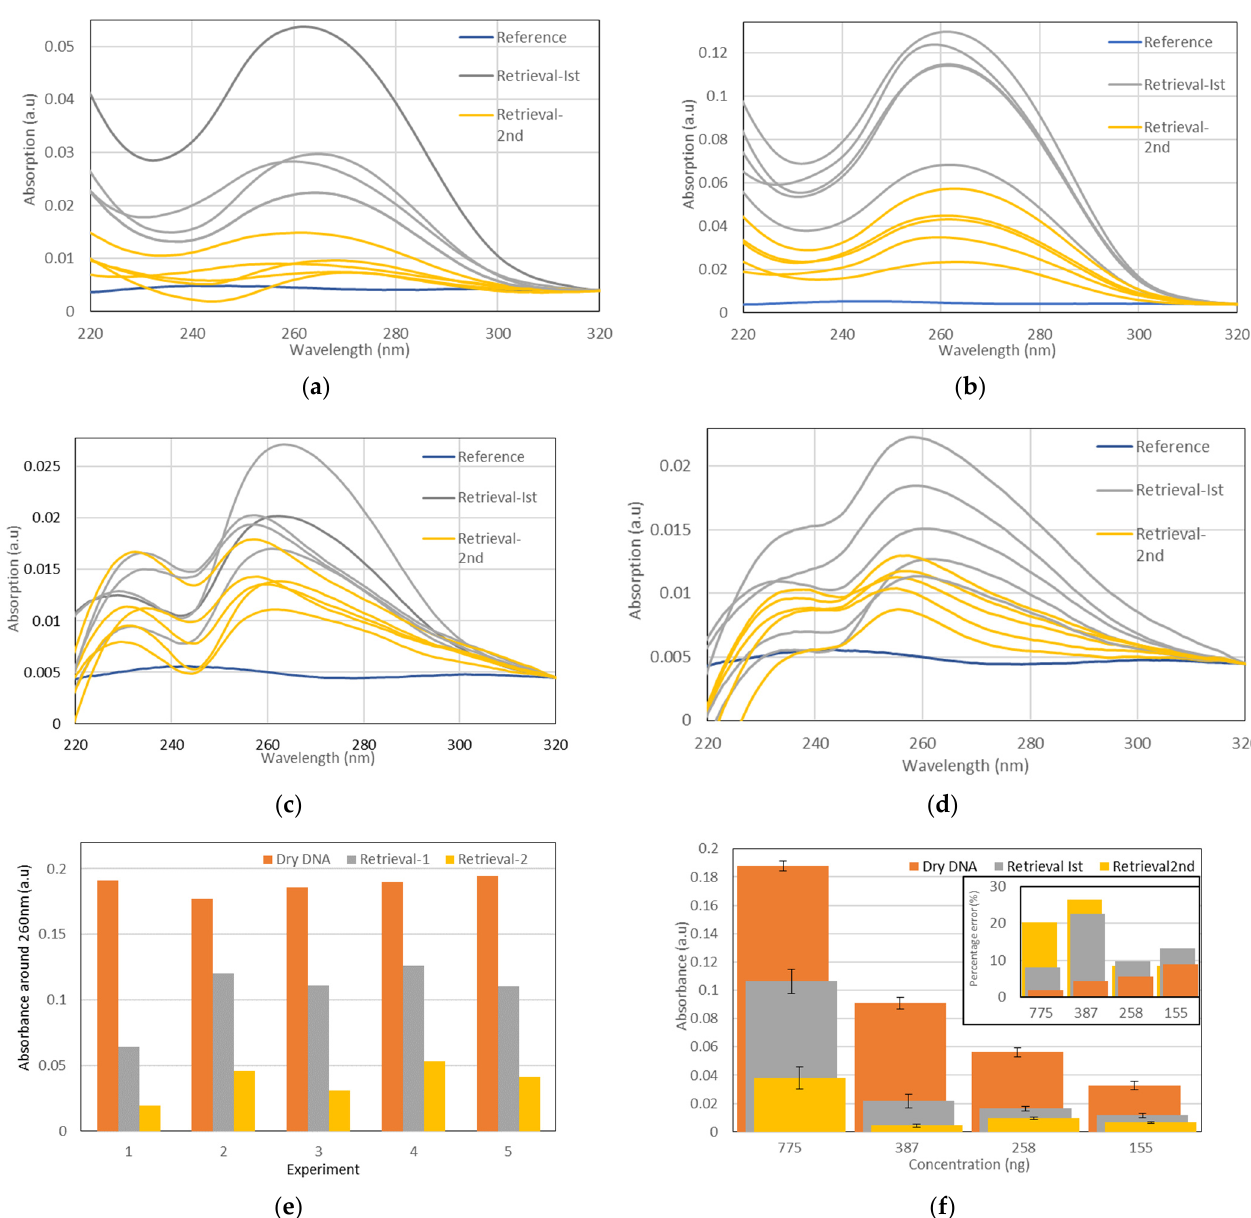
Figure 9. Absorption spectra of dry-state DNA after the first and second retrieval process for ( a ) 775 ng, ( b ) 387 ng, ( c ) 258 ng, and ( d ) 155 ng; ( e ) Obtained peak absorbance values of five 775 ng dry-state DNA; ( f ) Obtained average peak absorbance values of 775 ng, 387 ng, 258 ng, and 155 ng spectra, and their averages after the first and second retrieval processes with (inset) their corresponding percentage errors. Each value is an average of 5 peak absorbances.